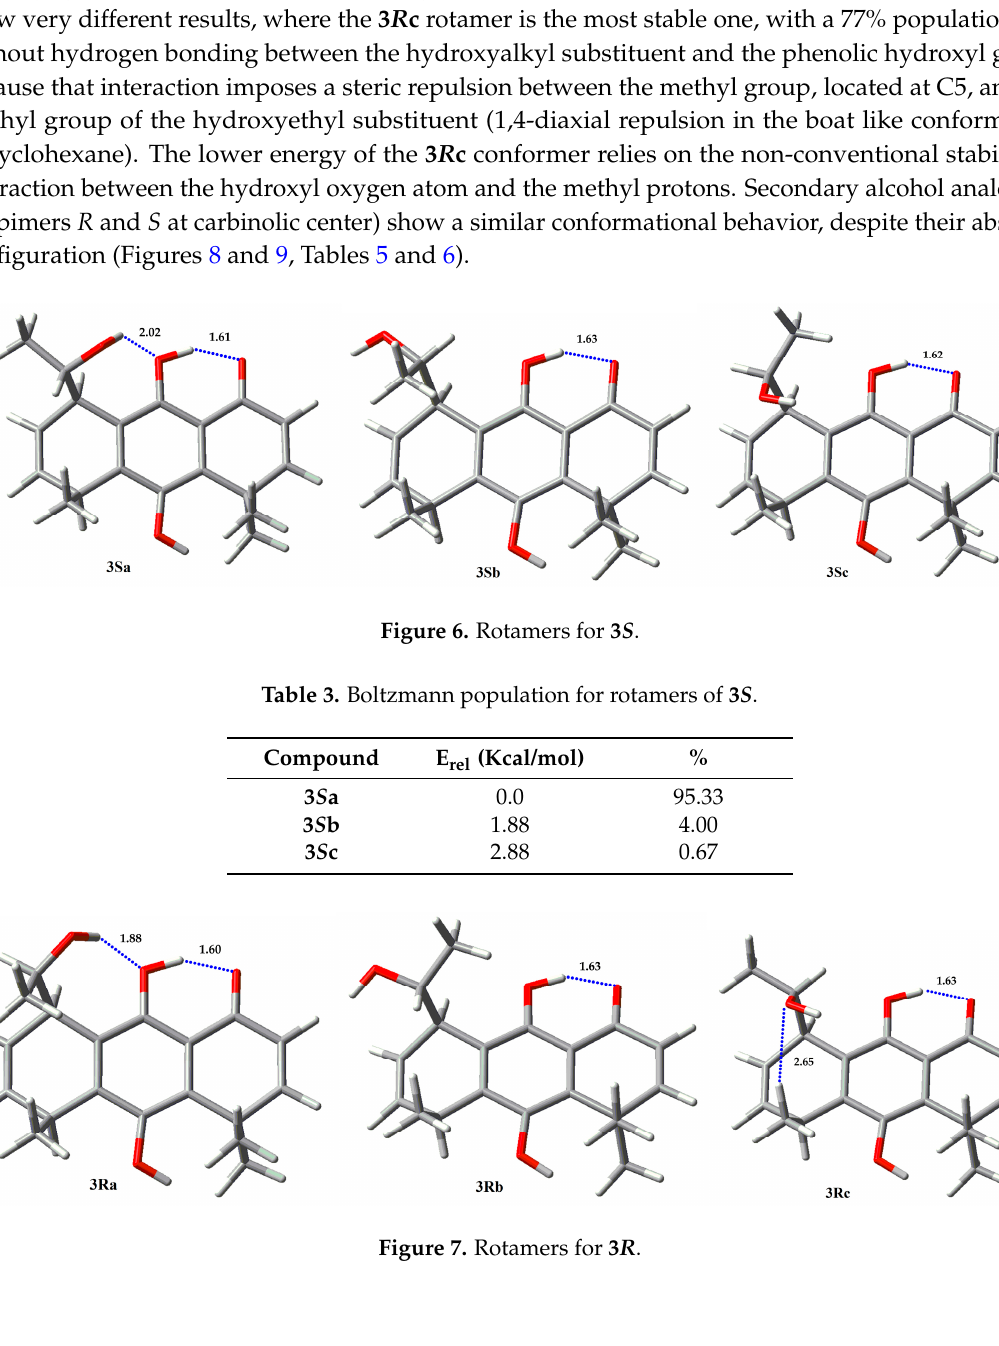
Table 2. Boltzmann population for rotamers of 2 .